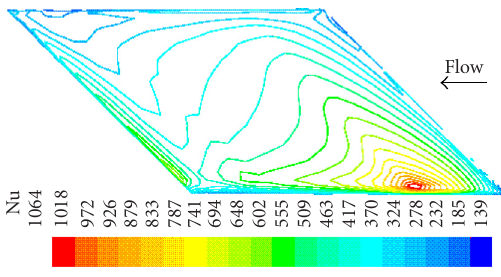
Figure 11: Representative iso-Nu contours on the surface area be- tween a pair of ribs.